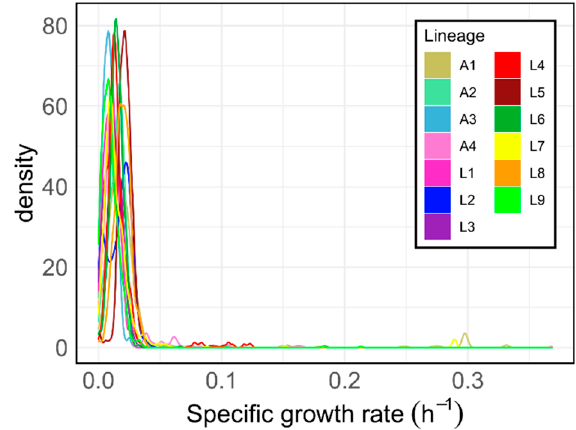
Figure 6. Density plots of biomass fluxes of the samples of each one of the lineage ‐ specific genome ‐ scale metabolic models . The solution space of each one of the models was sampled 1000 times in conditions mimicking Middlebrock 7H9 OADC + cholesterol and densities were obtained for each model.